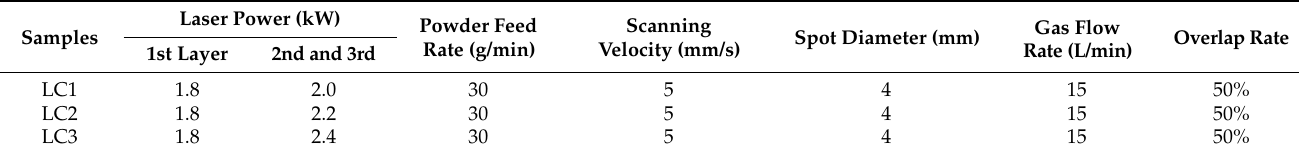
Table 2. Different parameters of laser